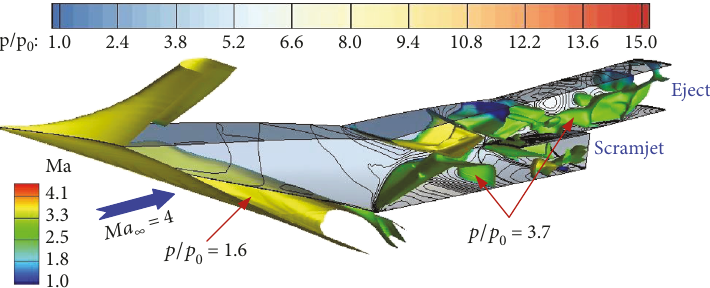
= 4 . The surface wall is contoured by the pressure ratio p/p ∞